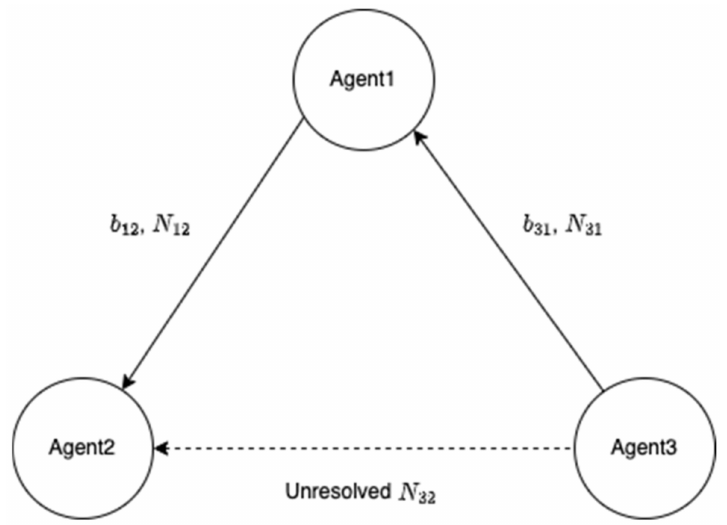
Figure 4. Updated baselines and DD integer ambiguities after implementing an antenna array- aided